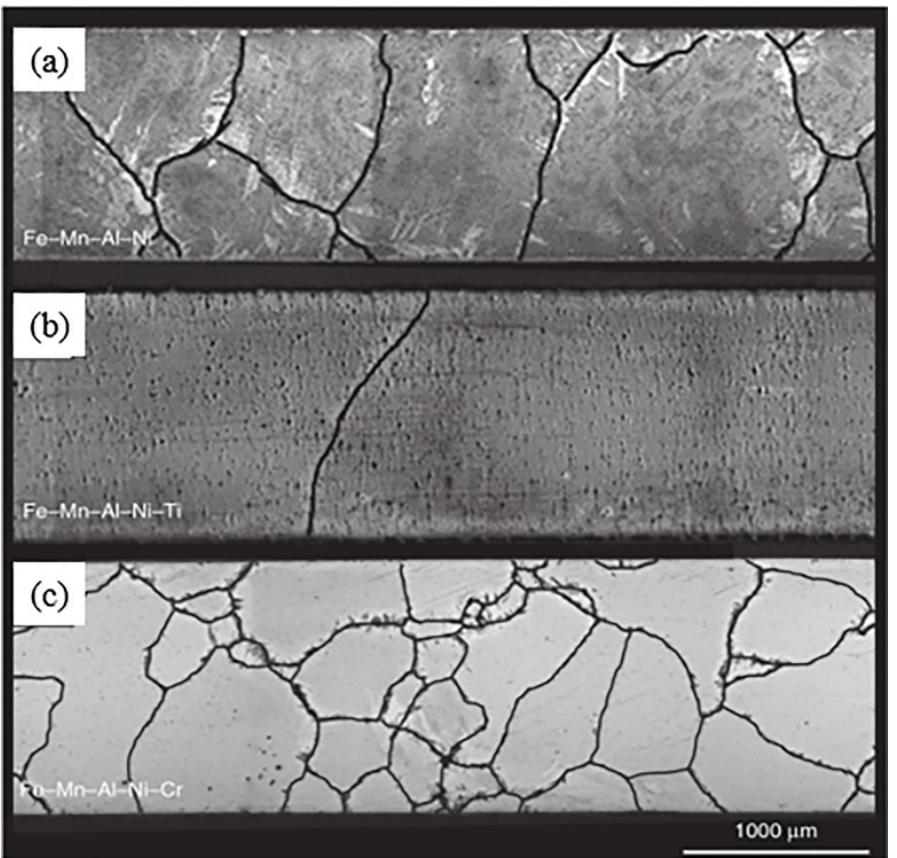
Figure 9. Microstructures after a single cycle of heat treatment: ( a ) Fe-Mn-Al-Ni; ( b ) Fe-Mn-Al-Ni-Ti; ( c ) Fe-Mn-Al-Ni-Cr [109]. Reprinted with permission from Ref. [109]. Copyright 2019 Springer Nature.